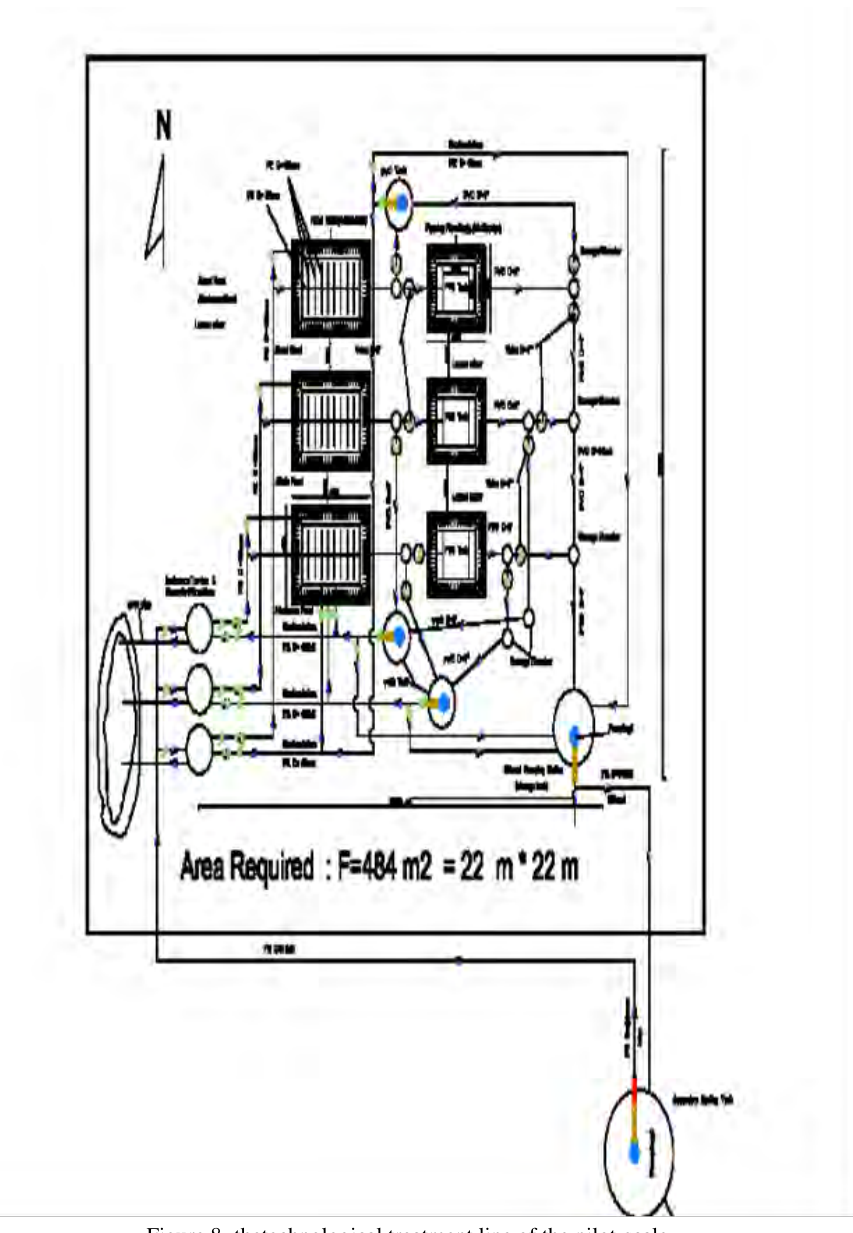
Figure 8. thetechnological treatment line of the